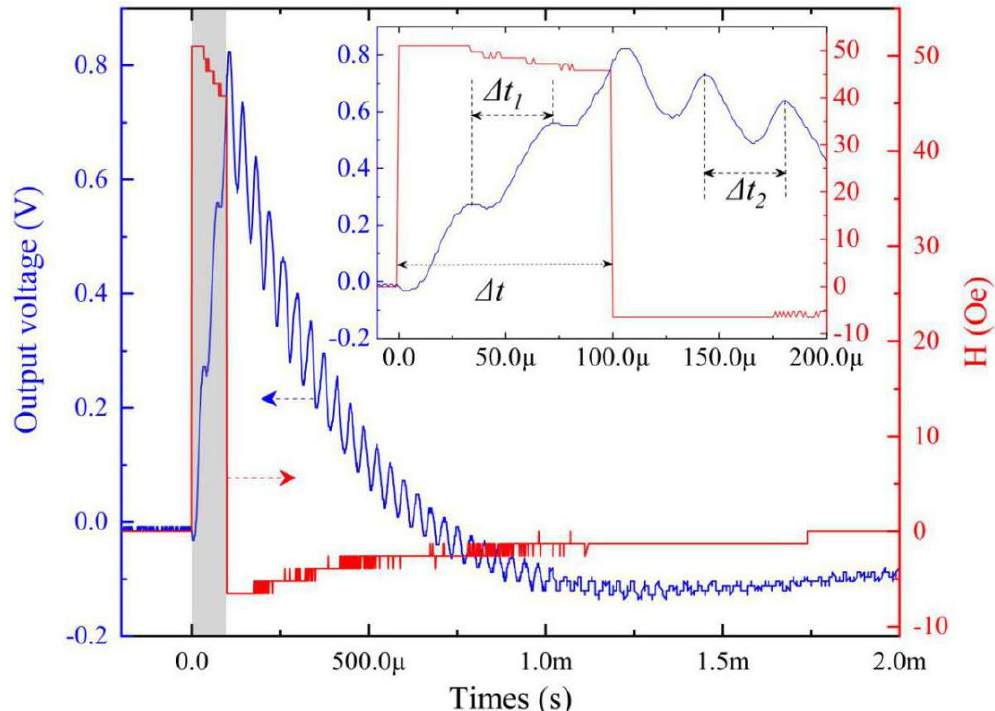
Figure 3. Time dependence output voltage V o of the FeCuNbSiB/piezofiber structure driven by the magnetic field pulse with a width ( Δt) of ~100 μs and an amplitude of 51 Oe. The inset shows the detail when times were 0 – 200 μs. The rise time of the pulse magnetic was ~8.4 ns. The bias magnetic field was set to zero.